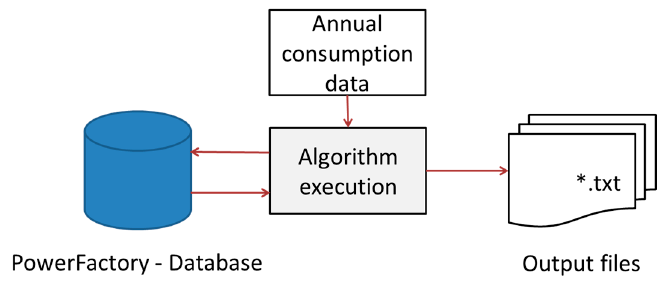
Figure 7. Simulation output.